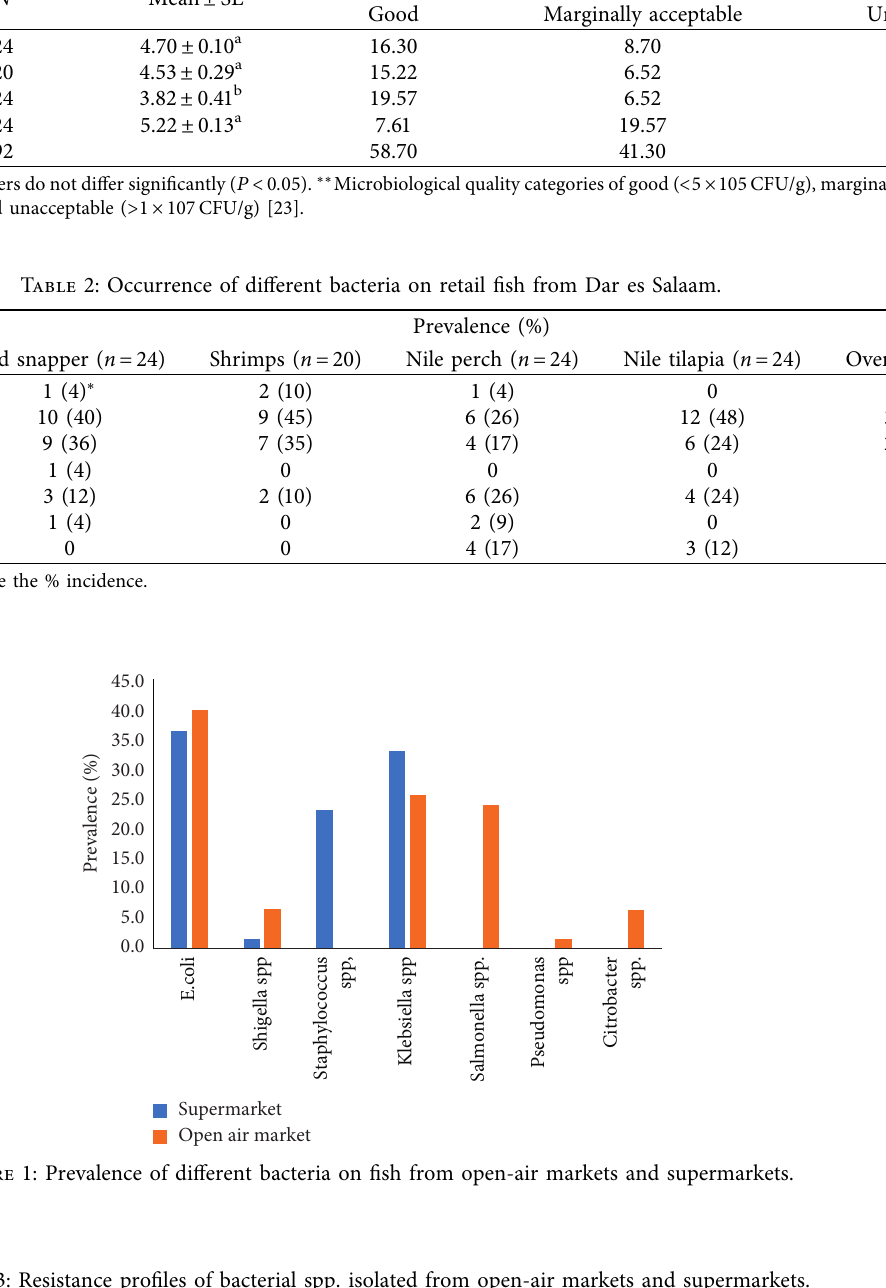
Table 1: Mean total viable counts of retail fish in log10 CFU per gram ± standard error (SE). Fish species